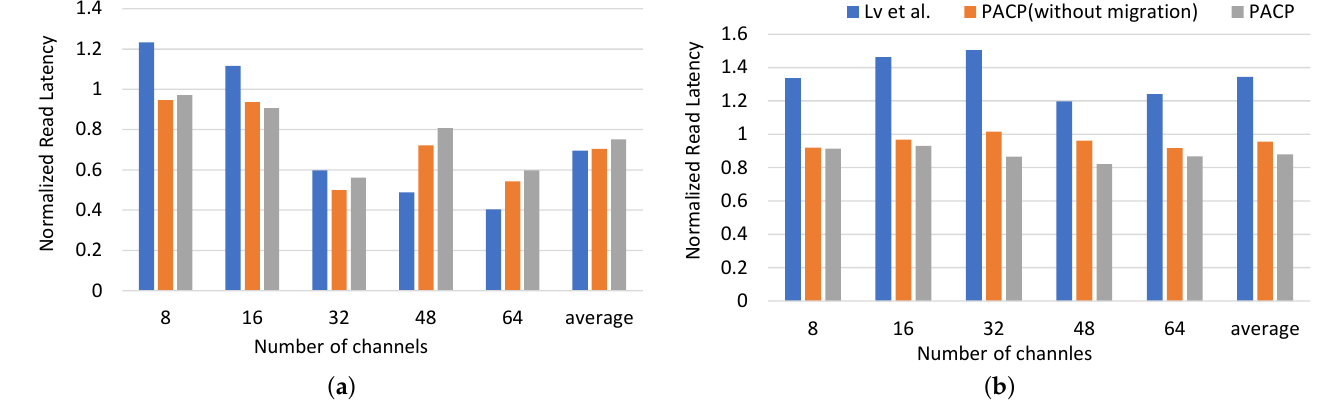
Figure 9. Read latency comparison under different interference conditions: ( a ) high-interference